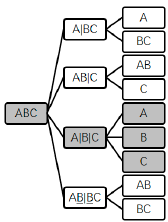
Table 7. The costs of nonsharp sequences of the four-component alkane case. Number TAC (Dollar) Containing Dividing Wall Column or Not